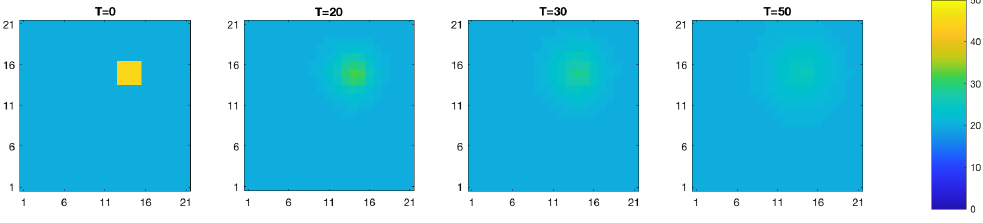
Figure 13. True temperature ( ◦ C) field evolution over